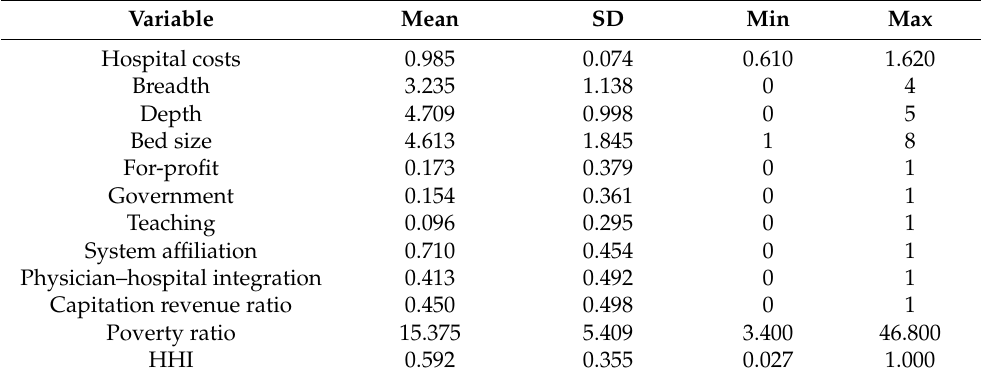
Table 1. Descriptive